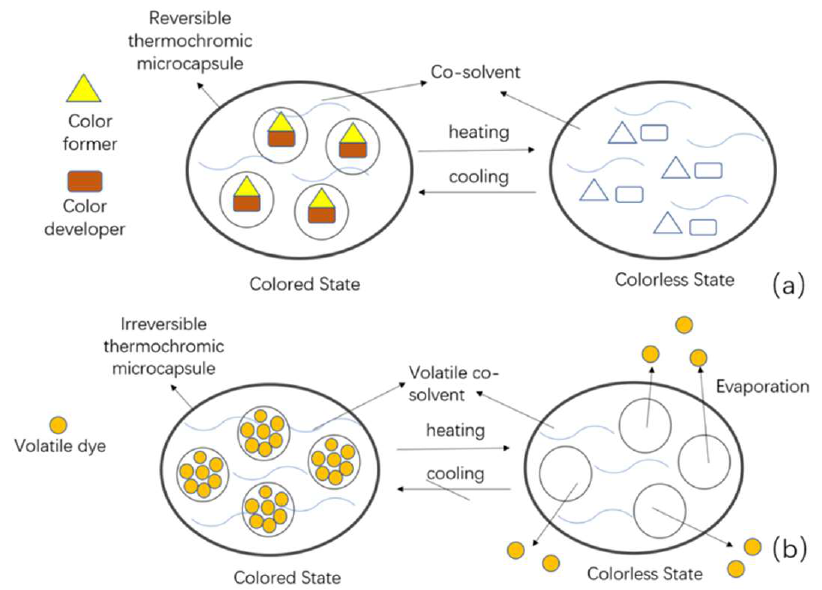
Figure 2. Mechanisms of action of thermochromic microcapsules during heating and cooling. ( a ) Reversible and ( b ) irreversible.